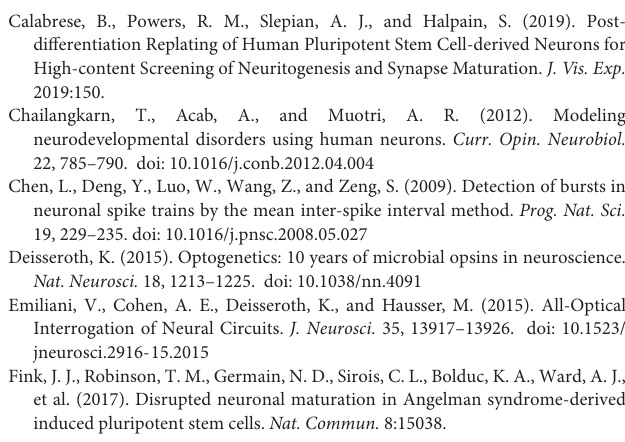
Supplementary Figure 4 | Effect of picrotoxin on spontaneous firing of primary neurons. Perfusion with 50 µ M picrotoxin increases the activity in rat hippocampal neurons. Voltage time-courses obtained from six representative neurons show spontaneous activity prior to pharmacological stimulation (left) and an increase in firing and bursting activity under 50 µ M picrotoxin (PTX, right). Supplementary Figure 5 | Generation of monolayer cultures of hiPSC-derived neurons. (A) Transmitted light image of NPCs (scale bar, 200 µ m) plated on 10-cm Petri dishes. (B) Transmitted light image of NPCs culture that reached a confluency of 90%, which is the point when bFGF was withdrawn to start differentiation. Scale bar, 200 µ m. (C) Transmitted light image of developing human neurons after 4 weeks of differentiation with long and robust connections. Scale bar, 200 µ m. (D) hiPSC-derived neuronal cultures after ∼ 8 weeks of differentiation in 10-cm Petri dishes, without replating. Transmitted light images show formation of clusters (i), detached cells (ii, left) and clumps of cells on top of each other (ii, right). Clumps of cells from human neurons, which have been differentiating for 8 weeks, stained with BeRST-1 and loaded with OGB1 (iii). Scale bars, 50 µ m. (E) Replating into 35-mm imaging plates at week 4–5 of differentiation allows formation of homogenous and sparse neuronal cultures. The culture was immune-stained with MAP2 (red), the nuclei were counterstained with DAPI (blue). Scale bar, 50 µ m. (F) Monolayer cultures facilitate expression of CheRiff-EGFP via lentiviral transduction. The epifluorescence images show representative examples of CheRiff-EGFP-expressing neurons 10 days after the viral transfection. (G) Human neurons after 10 weeks of differentiation, which were replated at week 4. The transmitted light image shows a homogenous, monolayer culture cells with no clustering. The immunostaining image indicates mature neurons expressing MAP2 (red) and CheRiff-EGFP (green). The nuclei were counterstained with DAPI (blue). Scale bar, 200 µ m. (H) hiPSC neurons were imaged between week 9 and 10 of differentiation. Top: Epifluorescence images of cells loaded with OGB1 and stained with BeRST-1. Bottom: three representative BeRST-1 traces of spontaneous